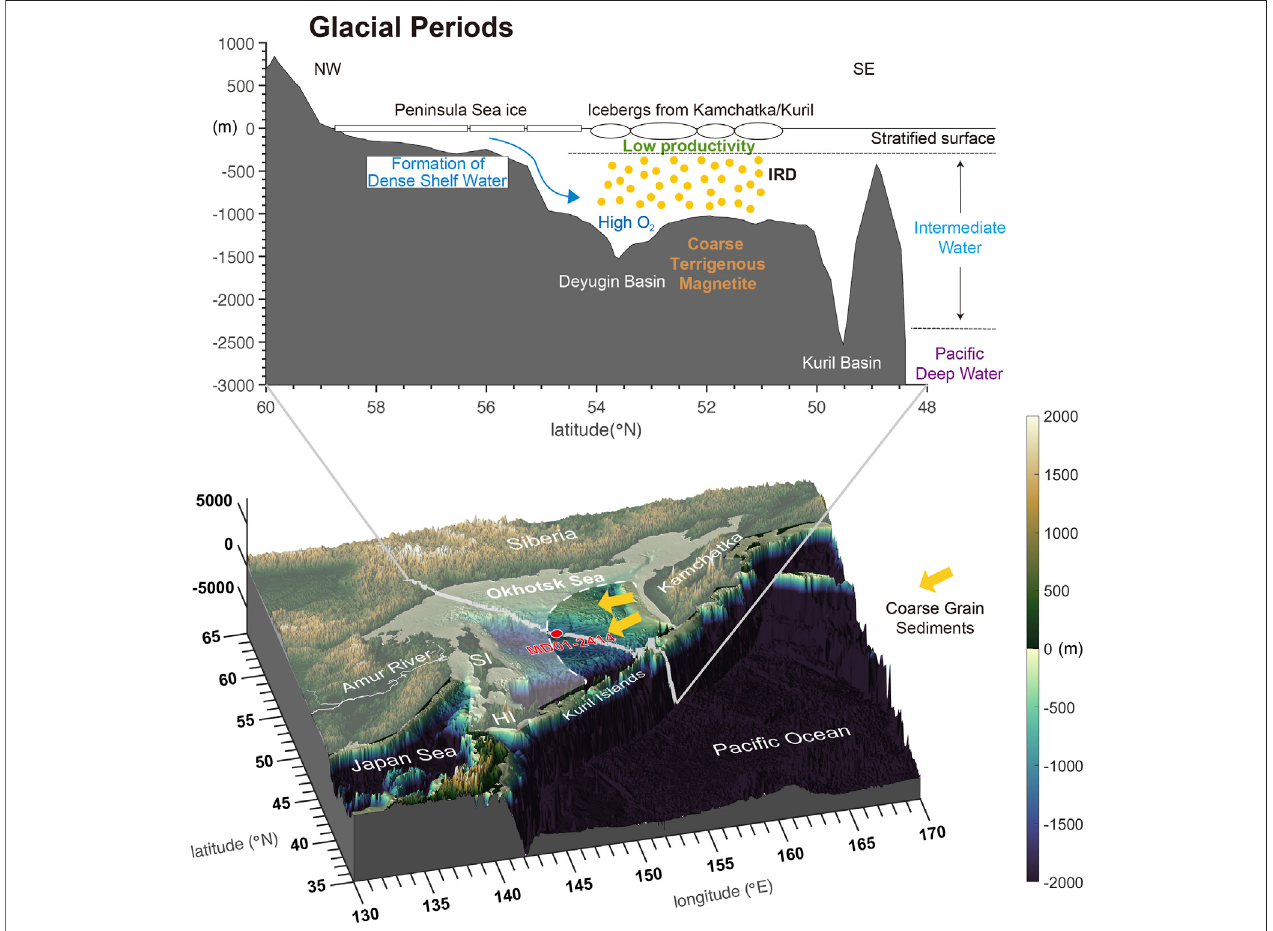
FIGURE 7 | Schematic cross-section and view of Okhotsk sea displaying the terrigenous transportations and oceanographic conditions during glacial periods.